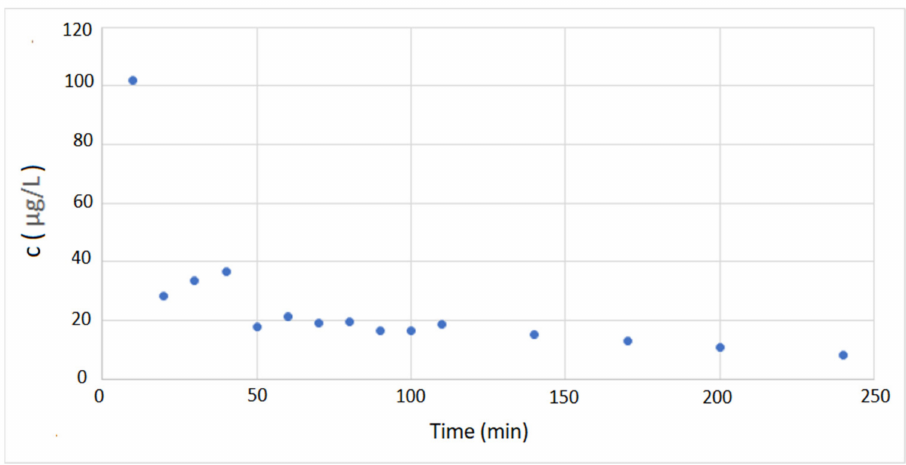
Figure 12. Carvacrol concentration in carbon dioxide as a function of time (CO 2 flow rate: 5 L/min, initial carvacrol content: